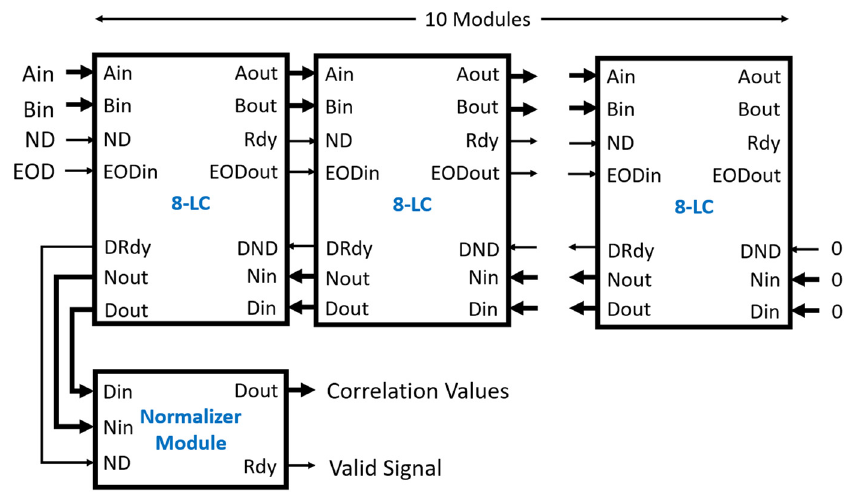
Figure 9. Linear correlator of 80 correlation values output. Input data are supplied to Ain and Bin with the control signals ND and EOD. The output of the correlator is from the Dout of the normalizer module. The Din and Nin of the last 8-LC module are set to zero and the DND is set to low.